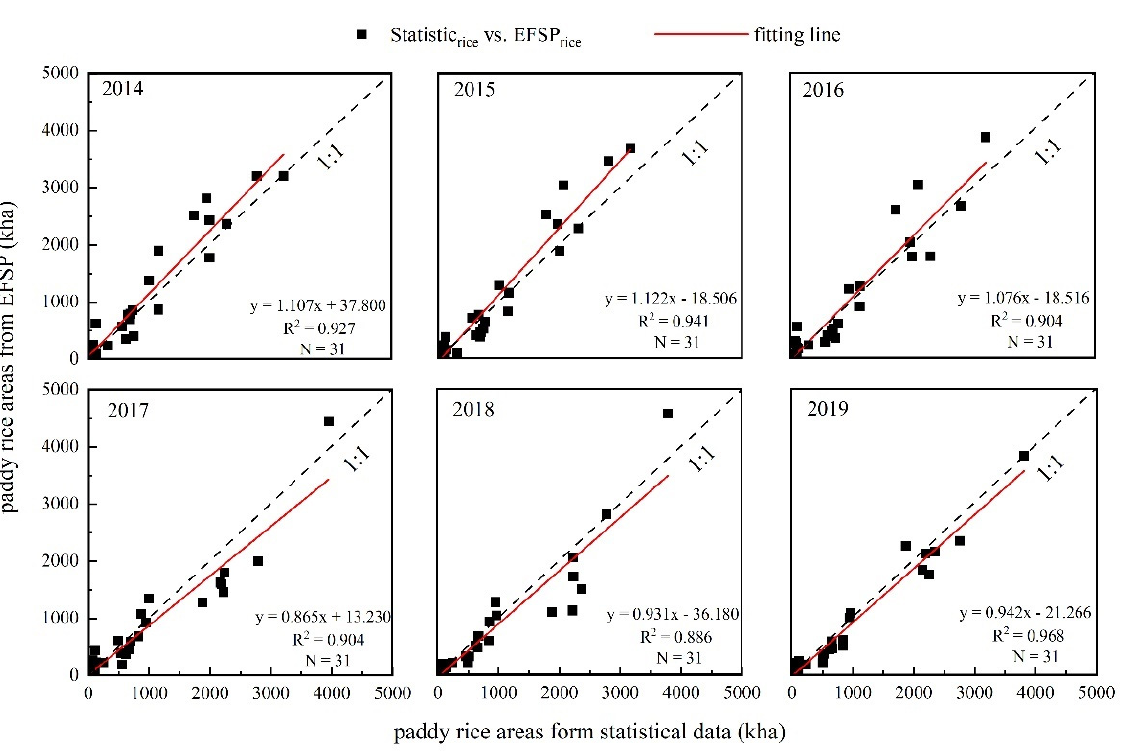
Figure 7. Paddy rice planting area from the map compared with Statistical Yearbooks at the province